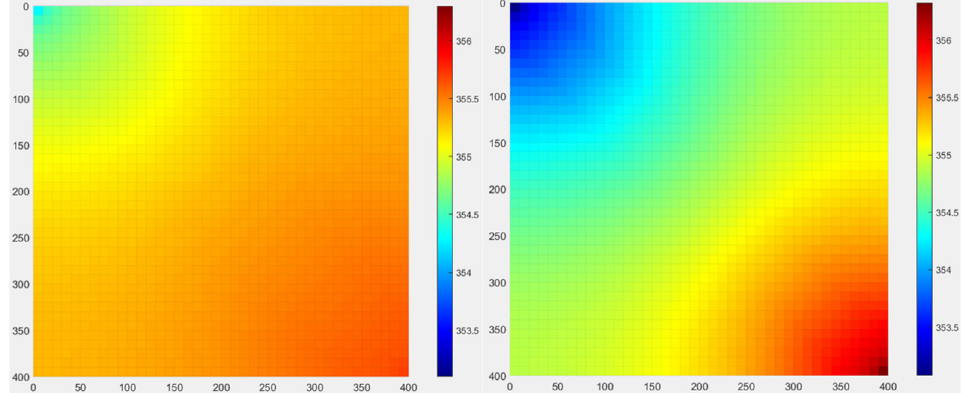
Figure 11. The water saturation distribution at the 50th time step (the left is the numerical simulation results considering the relative permeability of high waterflooding PVs, and the right is the traditional numerical simulation results).